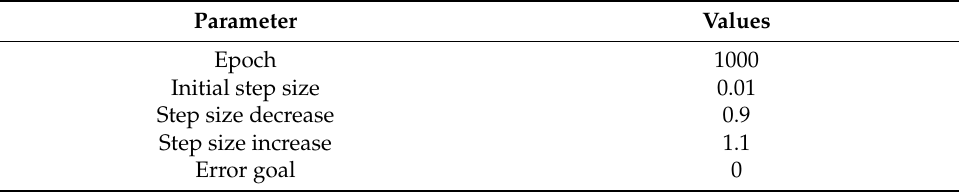
Table 2. Parameter settings for ANFIS